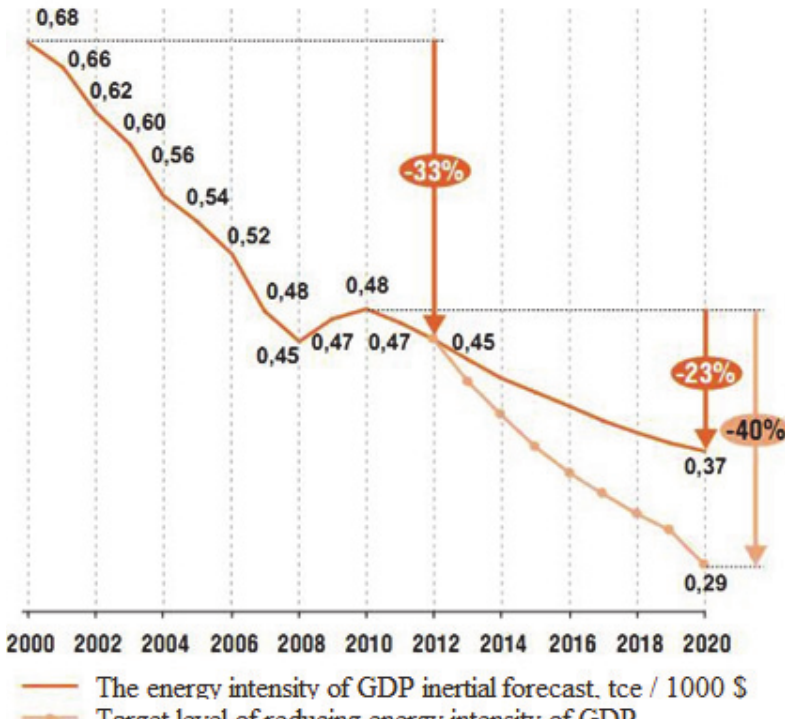
Fig. 1. The energy intensity of Russia’s GDP, 2000–2020 (Bogdanov,